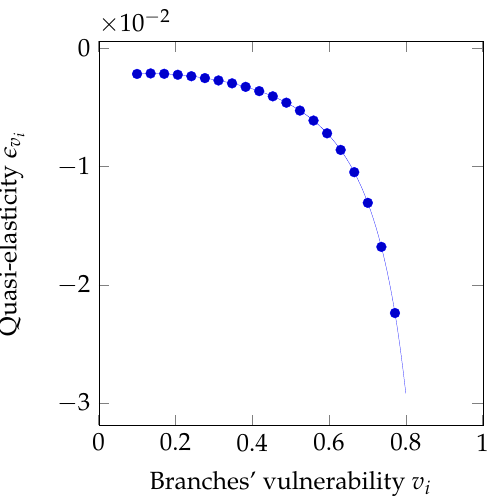
Figure 22. Sensitivity to branches’ vulnerability under limited liability.